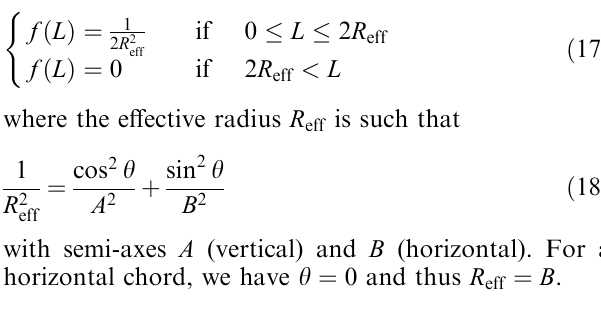
Fig. 3a, b. Cumulative frequency distributions of ice and water content ( IWC , in g m (cid:255) 3 ) and log-normal fitting: a for types Cb, Ci, Cs, Ns; b for types As, Sc, Cg, LwCg, OrCg. The error bar displayed is calculated using Eq. (16) and a relative accuracy of 10% on IWC. Its magnitude is roughly constant in the range of water contents